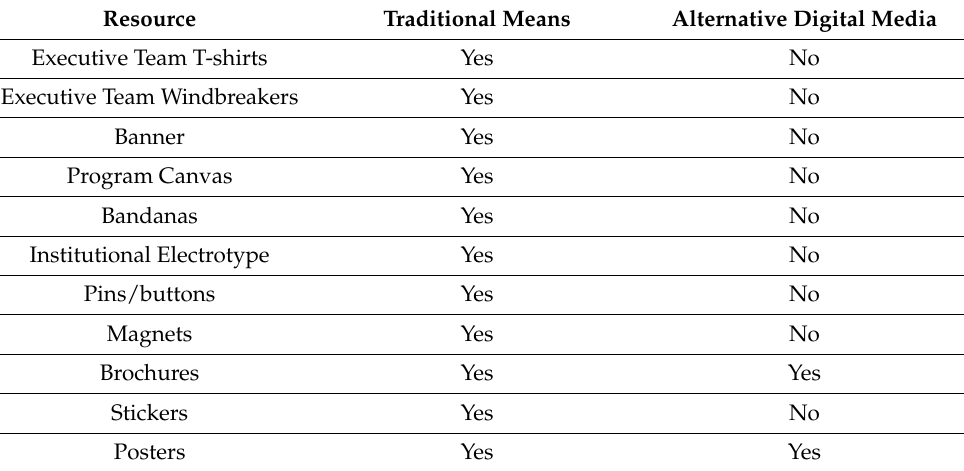
Table 2. Resources used for